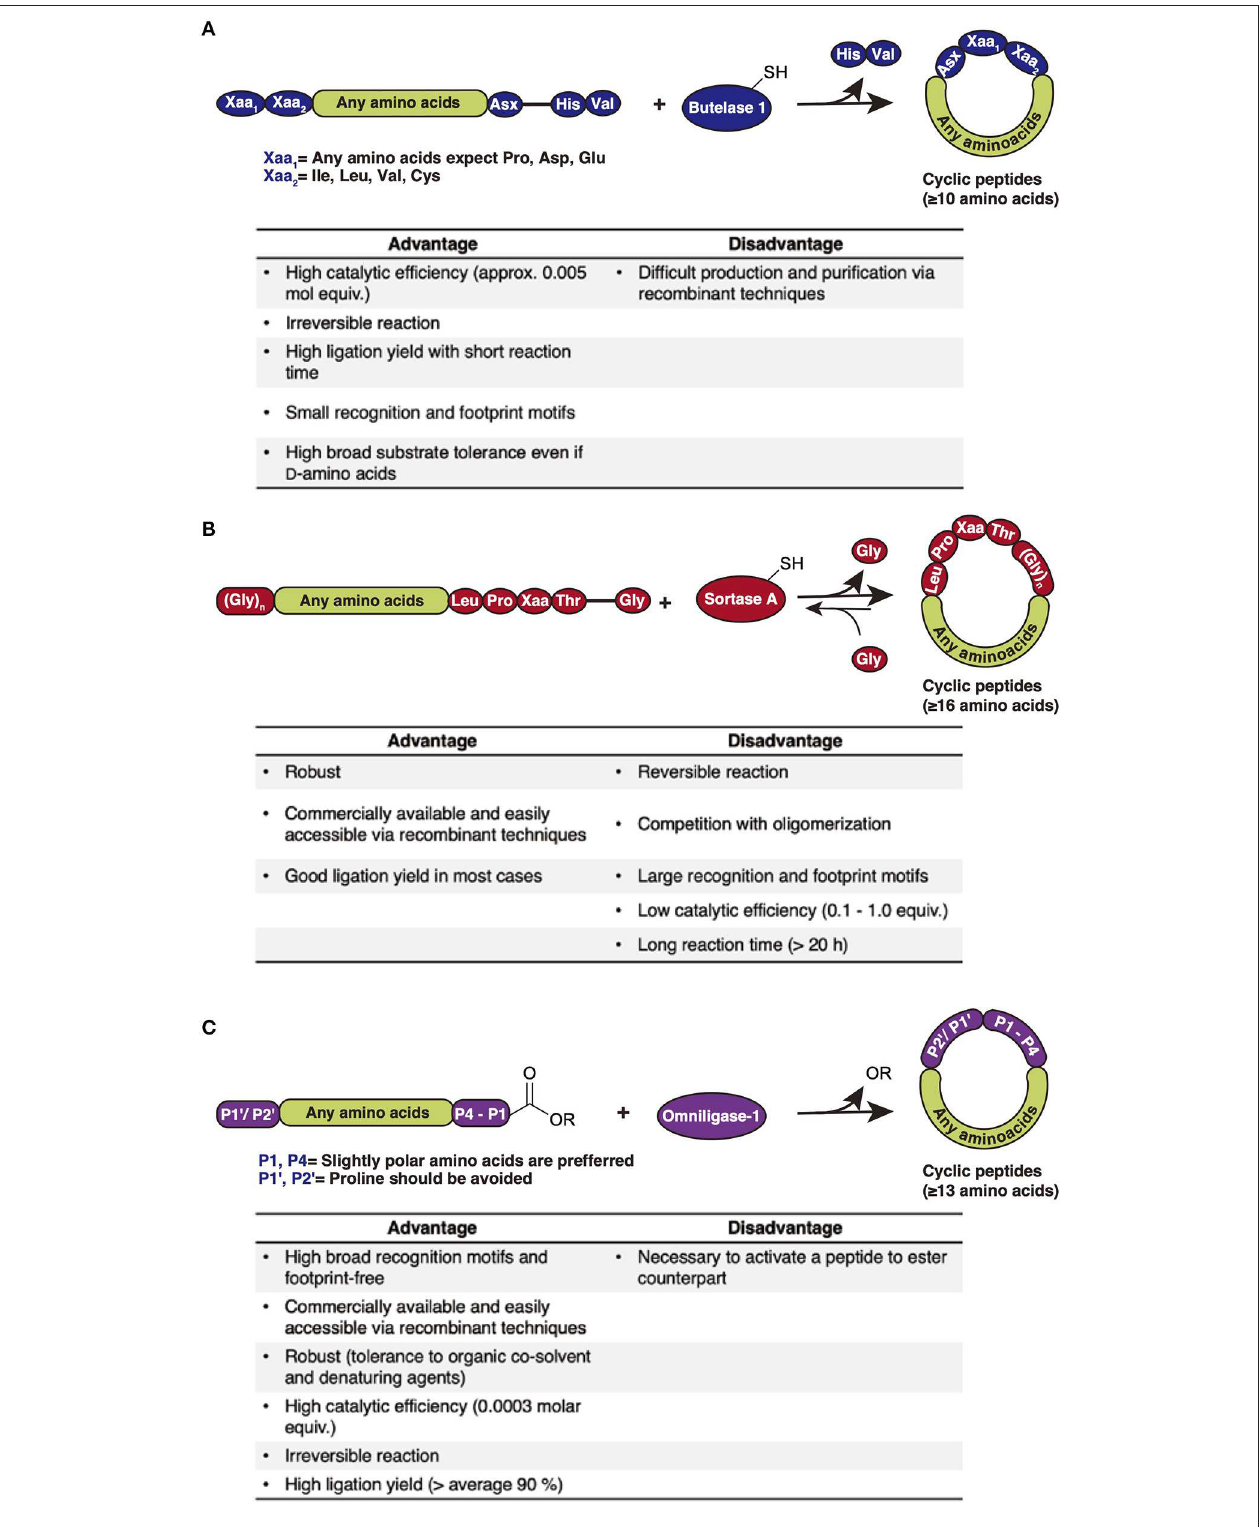
FIGURE 1 | Comparison of cyclization methods and their advantages and disadvantages (A) Asparaginyl endoprotease-mediated backbone cyclization (e.g., Buterase-1). Butelase 1 recognizes the C-terminal Asx-His-Val motifs to produce the corresponding backbone cyclic peptide containing the Asx-Xaa 1 − Xaa 2